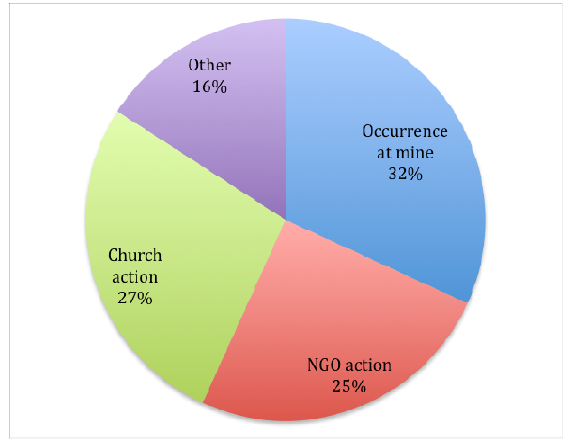
Figure 2: Event that sparked newspaper coverage of Guatemalan